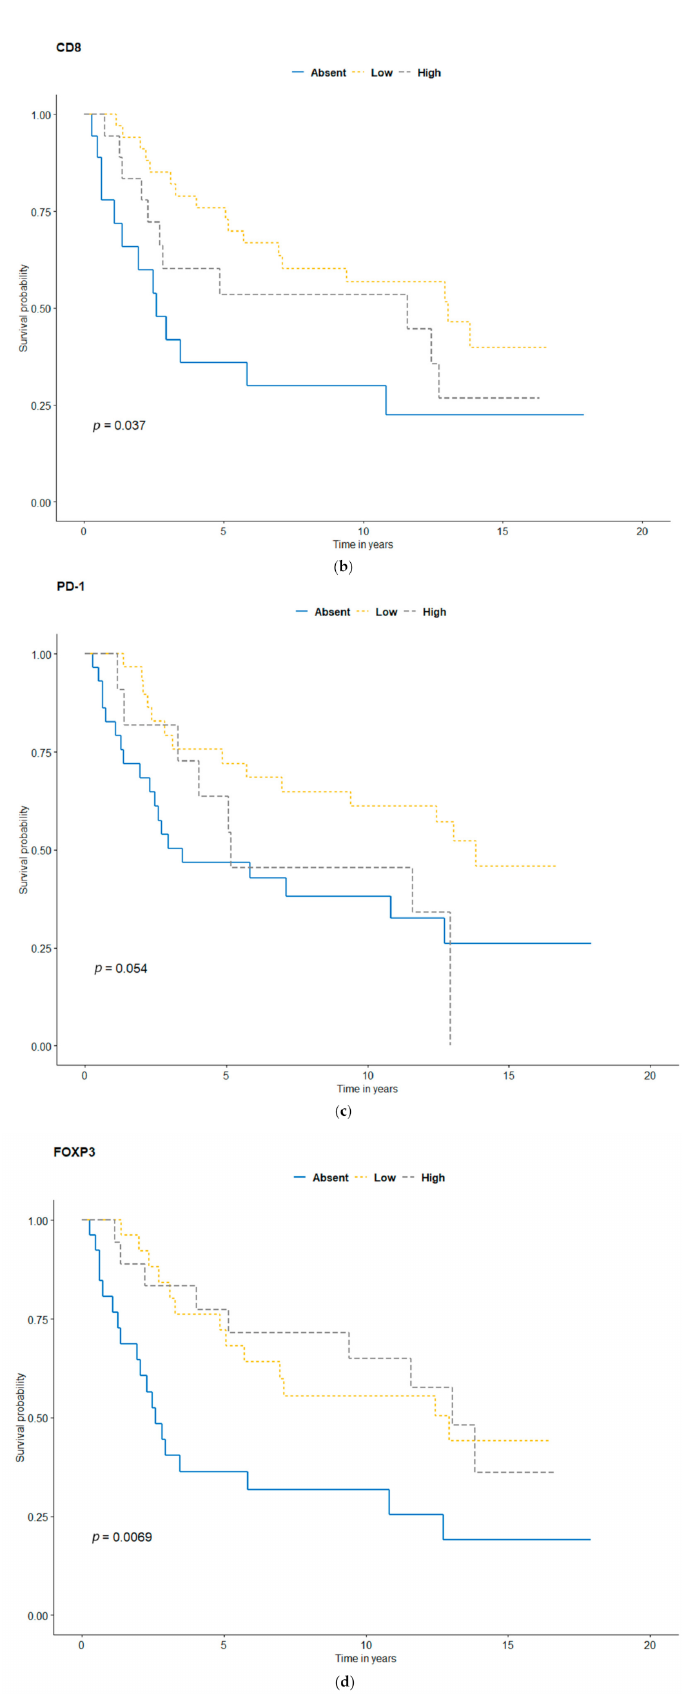
Figure 4. Kaplan-Meier survival curves for ( a ) CD4, ( b ), CD8, ( c ) PD-1, and ( d )